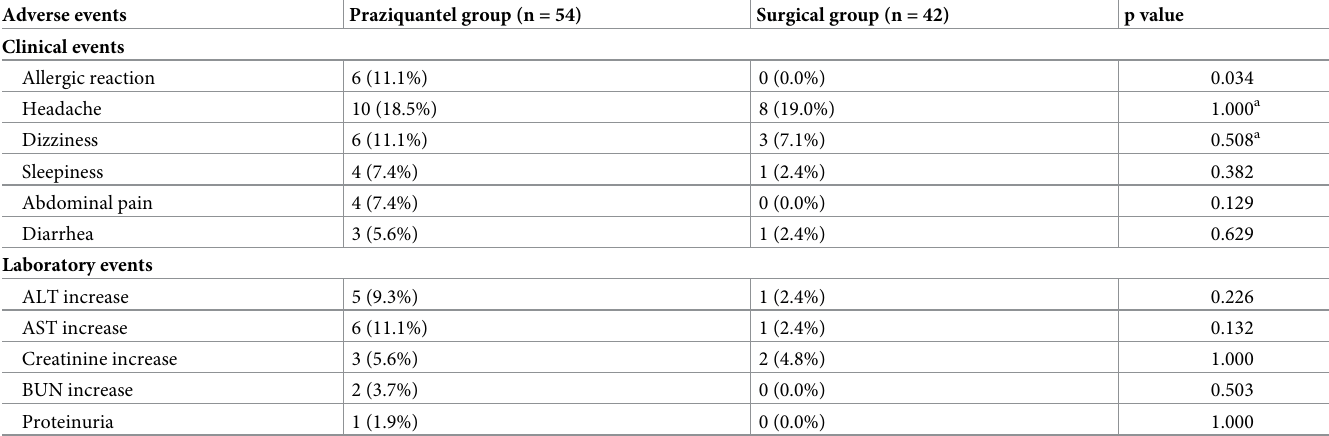
Table 4. Comparison of adverse events between the praziquantel and surgical